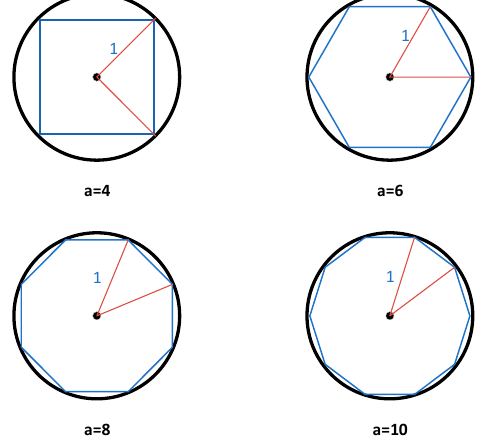
Figure 4. Cyclotomic method (with unit circle as an example).